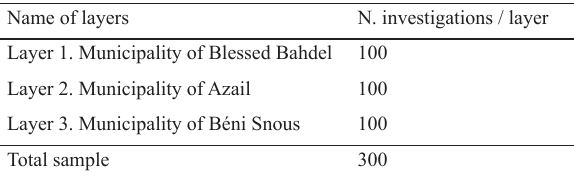
Table 1. Distribution of surveyed by each